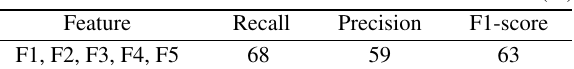
Table 6 All features used to detect the earthquake event in RBF kernel.